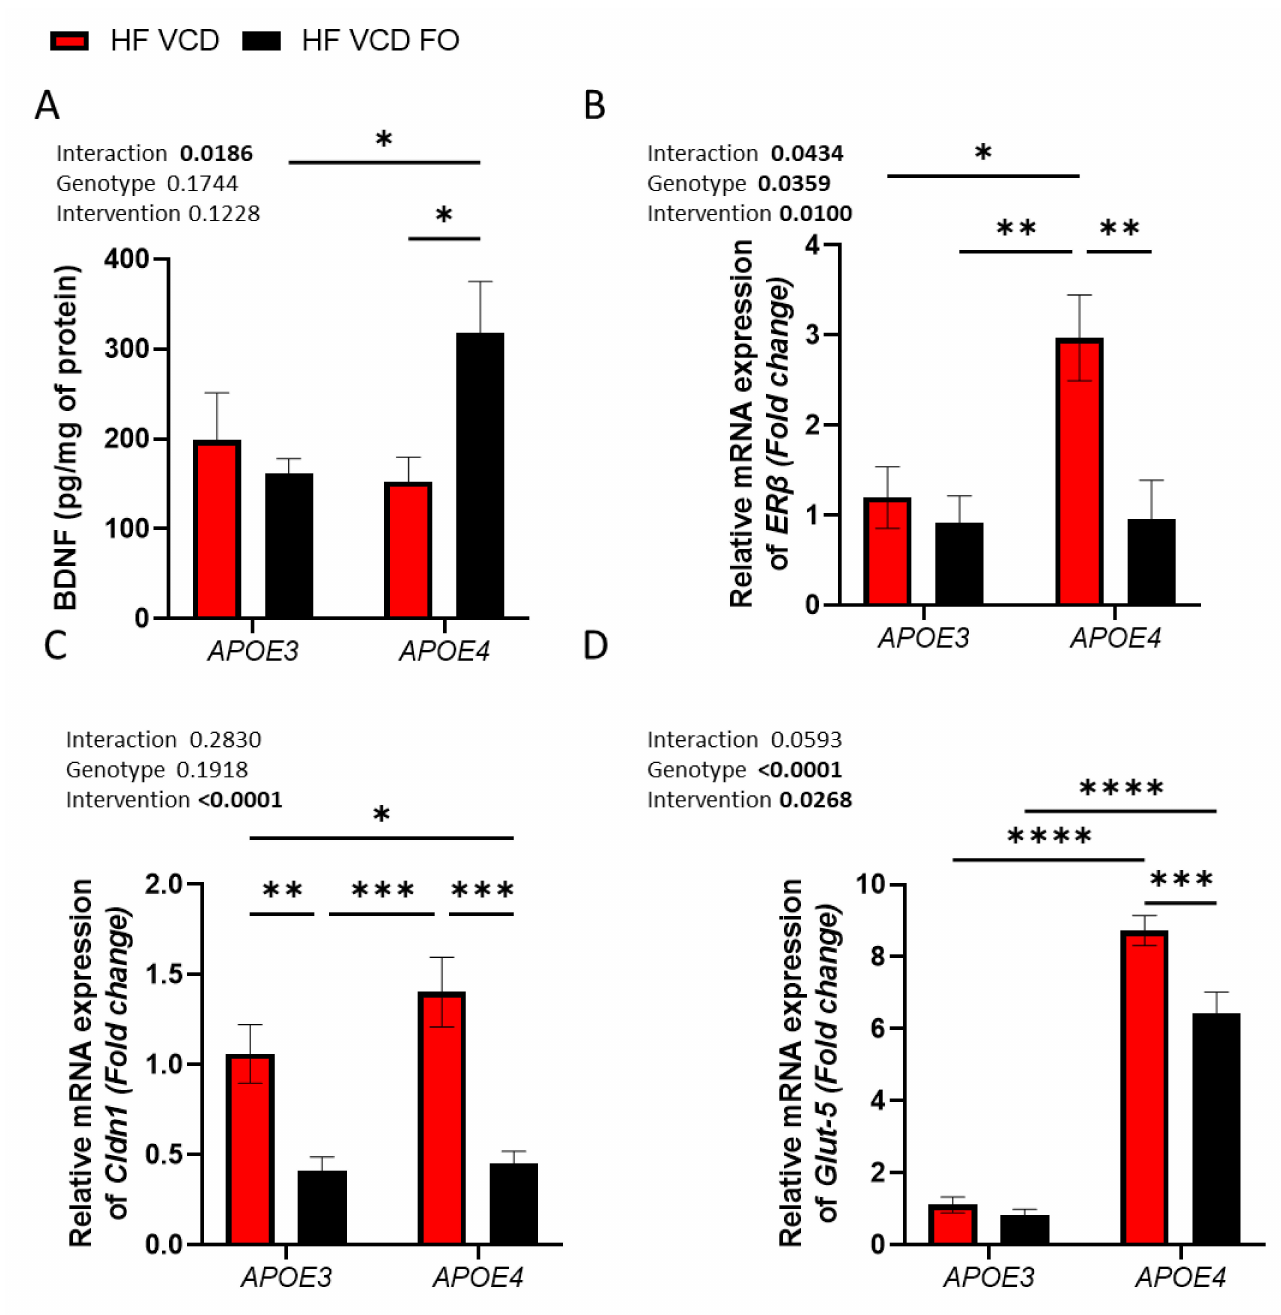
Figure 3. The effect of fish oil (FO) supplementation on molecular targets in APOE4 and VCD-induced dysregulation. ( A ) Addition of FO supplementation increased BDNF levels in only APOE4 animals. ( B ) Increased Er β expression observed in APOE4 VCD-treated animals was mitigated by FO sup- plementation. ( C ) Cldn1 was upregulated by VCD treatment; this expression was reduced across both genotypes through FO supplementation. ( D ) Expression of the fructose transporter Glut - 5 was considerably increased in APOE4 animals compared to APOE3 and was partially recovered by FO treatment. Data are presented as mean ± SEM; * p < 0.05, ** p < 0.01, *** p < 0.001, **** p <